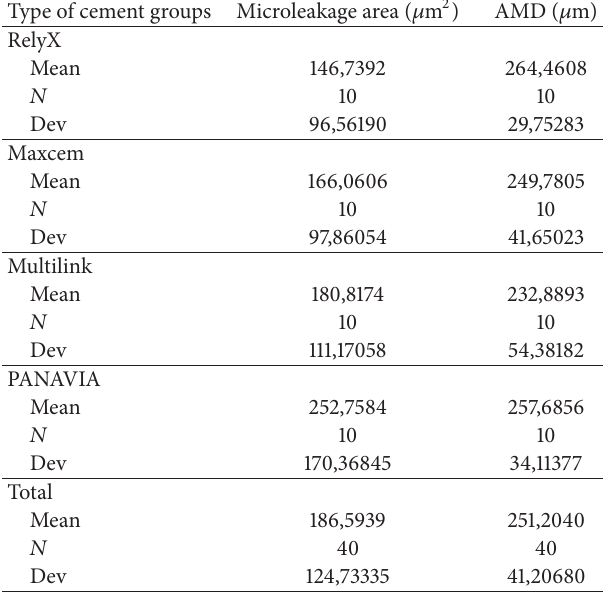
Table1:MicroleakageandAMDvaluesaccordingtotypeofcement. Type of cement